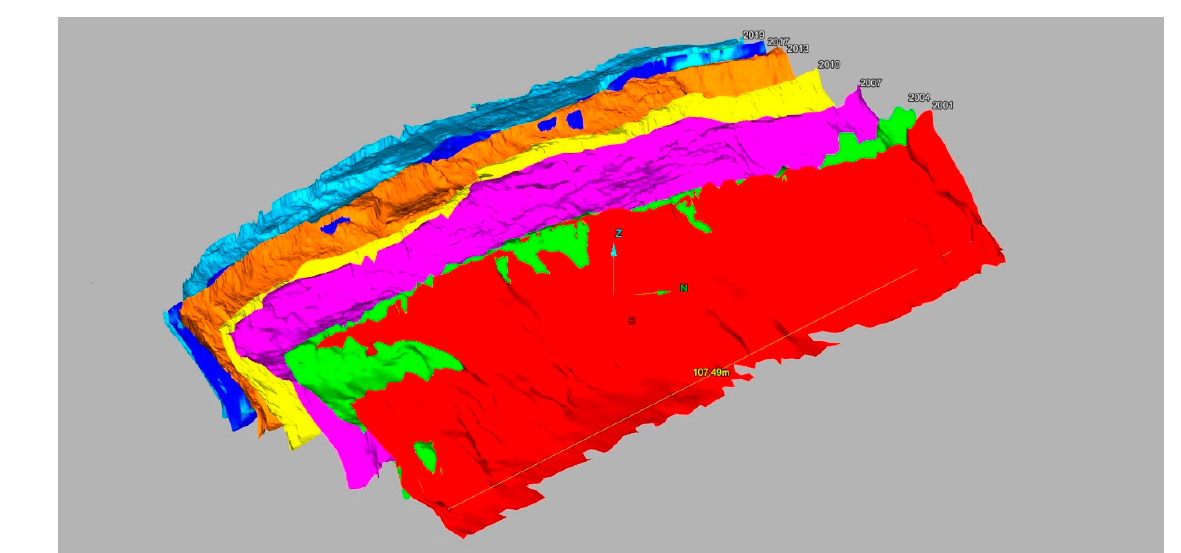
Figure 7. 3D models of the retreating cliff line at Aldbrough, 2001 to 2017.